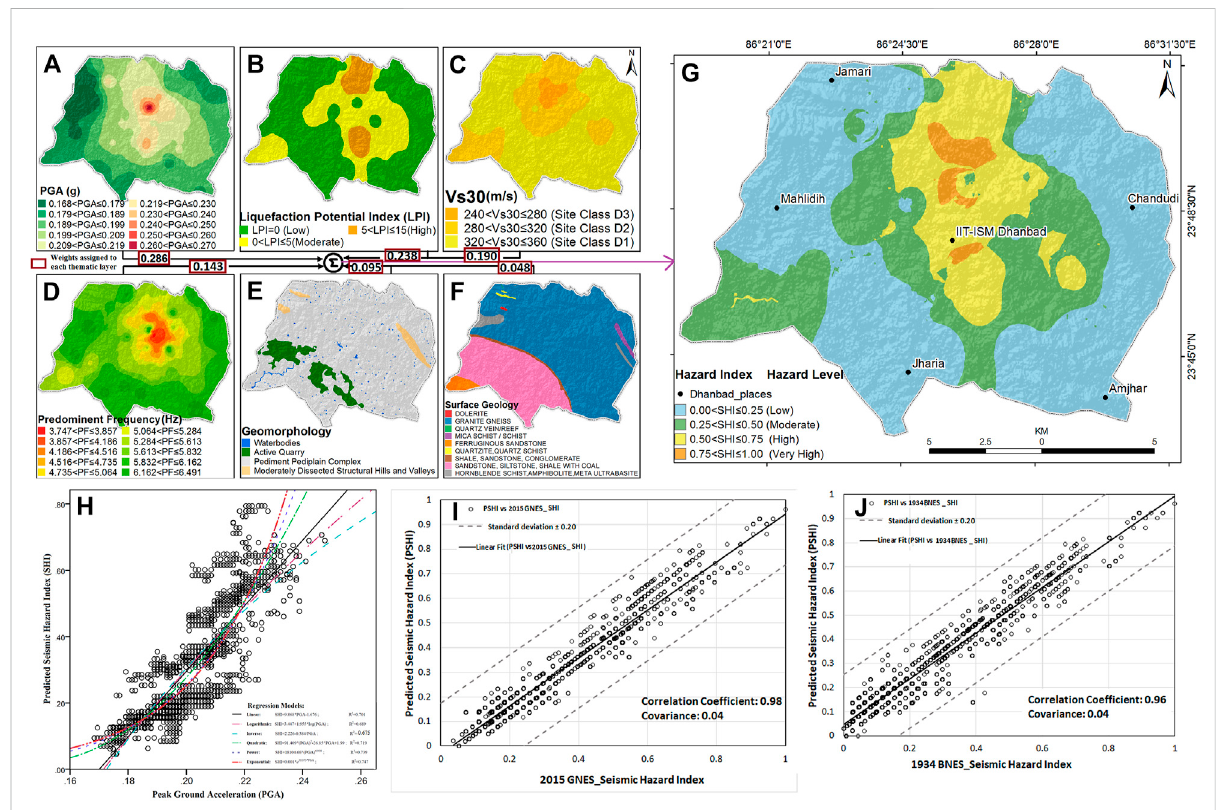
FIGURE 13 Preparation of the holistic seismic hazard microzonation map of Dhanbad on the GIS platform by overlaying (A) spatially distributed surface- consistent probabilistic peak ground acceleration for 475 years of return period on the geo-hazard thematic layers viz. (B) Probabilistic liquefaction potential index distribution, (C) site class map, (D) predominant frequency spatial distribution map, (E) geomorphology map (adopted from https:// bhukosh.gsi.gov.in/), and (F) surface geology map (adopted from https://bhukosh.gsi.gov.in/) by assigning individual weights of the order of 0. 286, 0.238, 0.190, 0.143, 0.095, and 0.048, respectively, using the analytic hierarchy process and integrating all the themes to produce seismic hazardmicrozonationmapofthecityasgivenin (G) .Variousregressionrelationsgivenin (H) workedoutbetweentheseismichazardindexandpeak ground acceleration depict an exponential fi t between the two variables. A direct correlation between the probabilistic seismic hazard index of the microzonation map with the scenario hazard theme created for 2015 Gorkha – Nepal earthquake of M W 7.8 through similar integration of scenario PGAwith theaforesaidgeo-hazard themesand theregression relation justworkout produce0.98 correlation coef fi cient betweenthetwovariables with a covariance of 0.04 as shown in (I) , while a similar exercise with 1934 Bihar – Nepal earthquake of M W 8.1 produces 96% correlation between these variables with a similar covariance of 0.04 as depicted in (J)